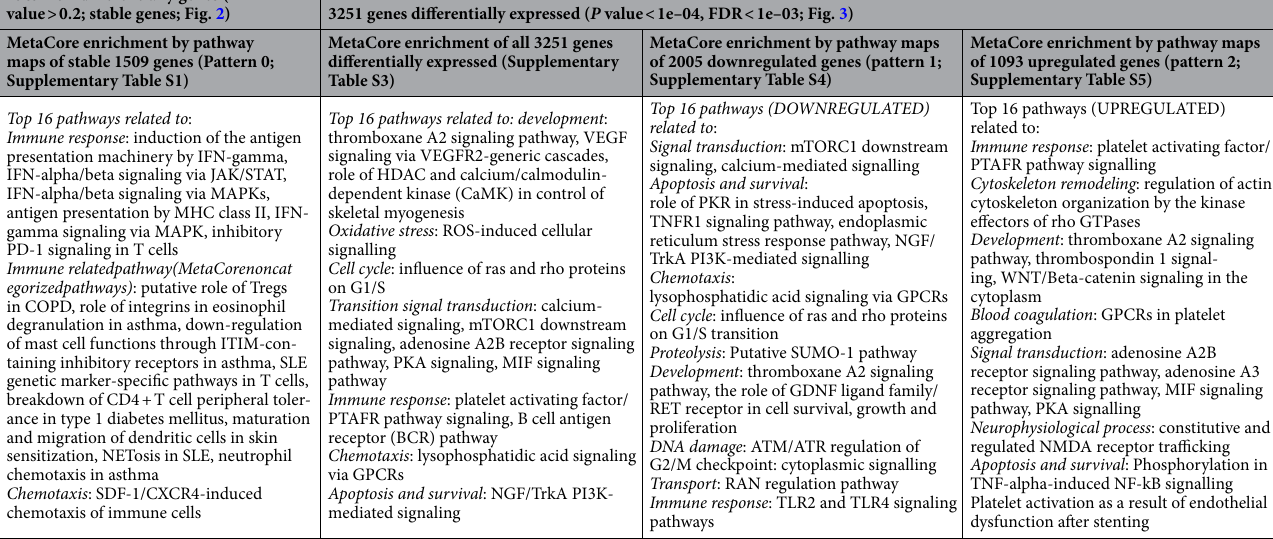
Table 2. Summary table of MetaCore enrichment analyses for differentially and non-differentially (stable)